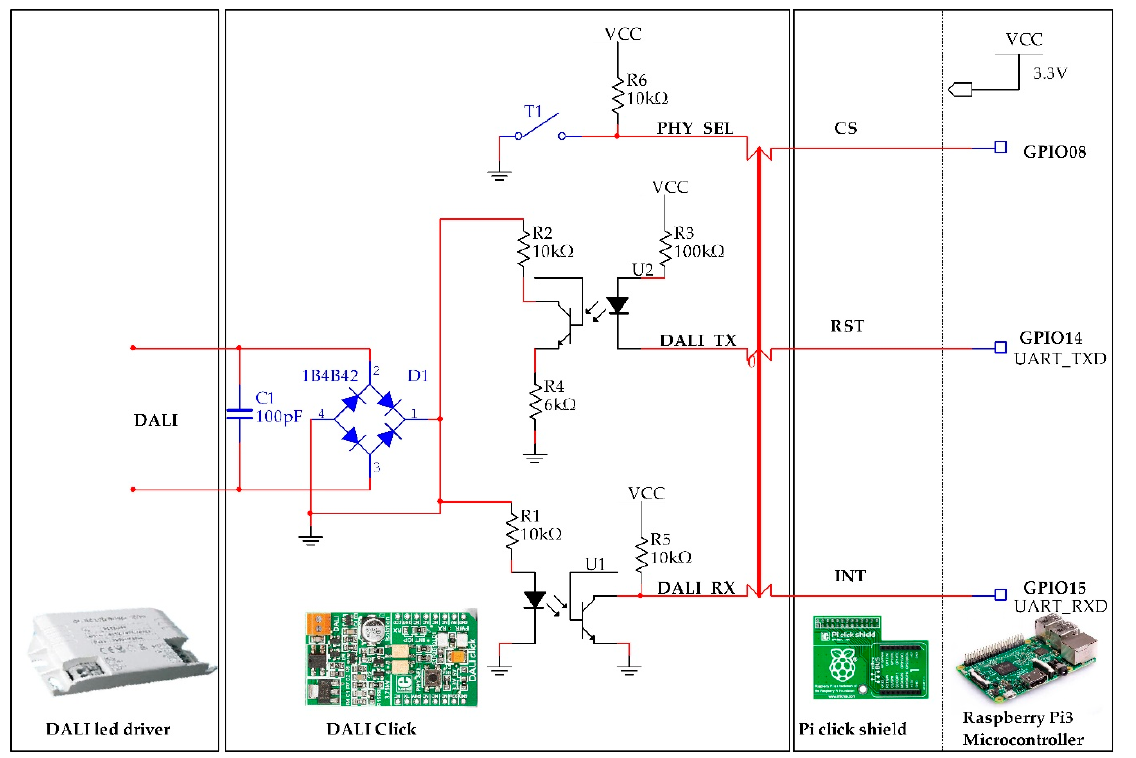
Figure 3. DALI interface and system connections.